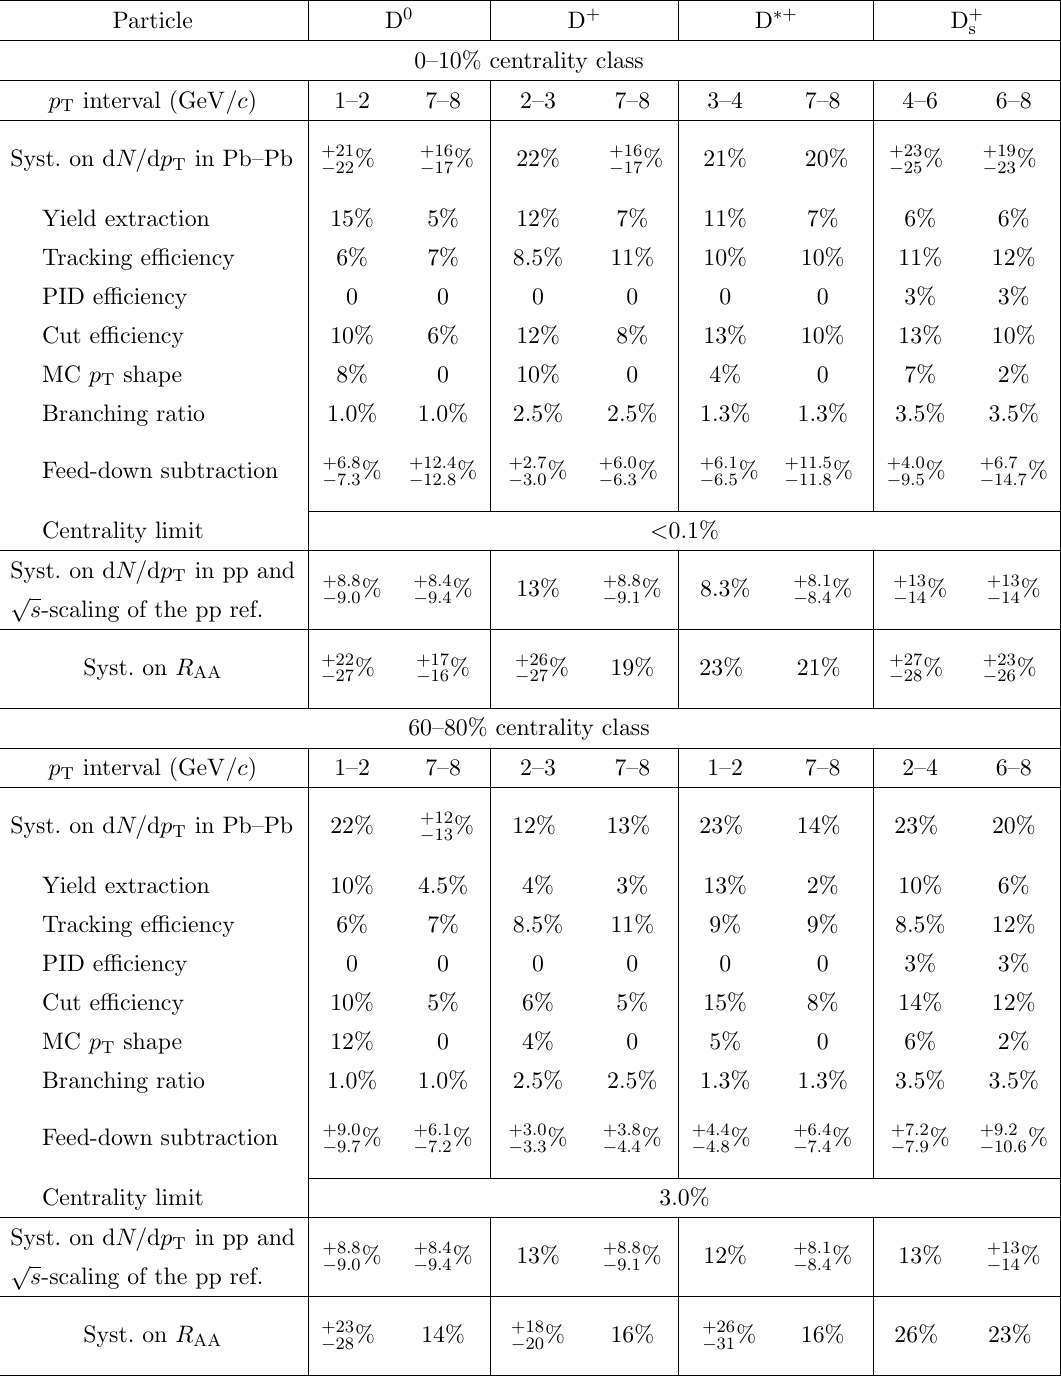
Table 2 . Relative systematic uncertainties on the d N= d p T in Pb{Pb collisions, on the extrapolated d N= d p T in pp collisions and on the R AA of D 0 , D (cid:3) + , D + , and D + in two centrality classes considered s in the analysis for the lowest accessible p T intervals and for the intermediate range 7 < p T < 8 GeV =c (6 < p T < 8 GeV =c for the D + s